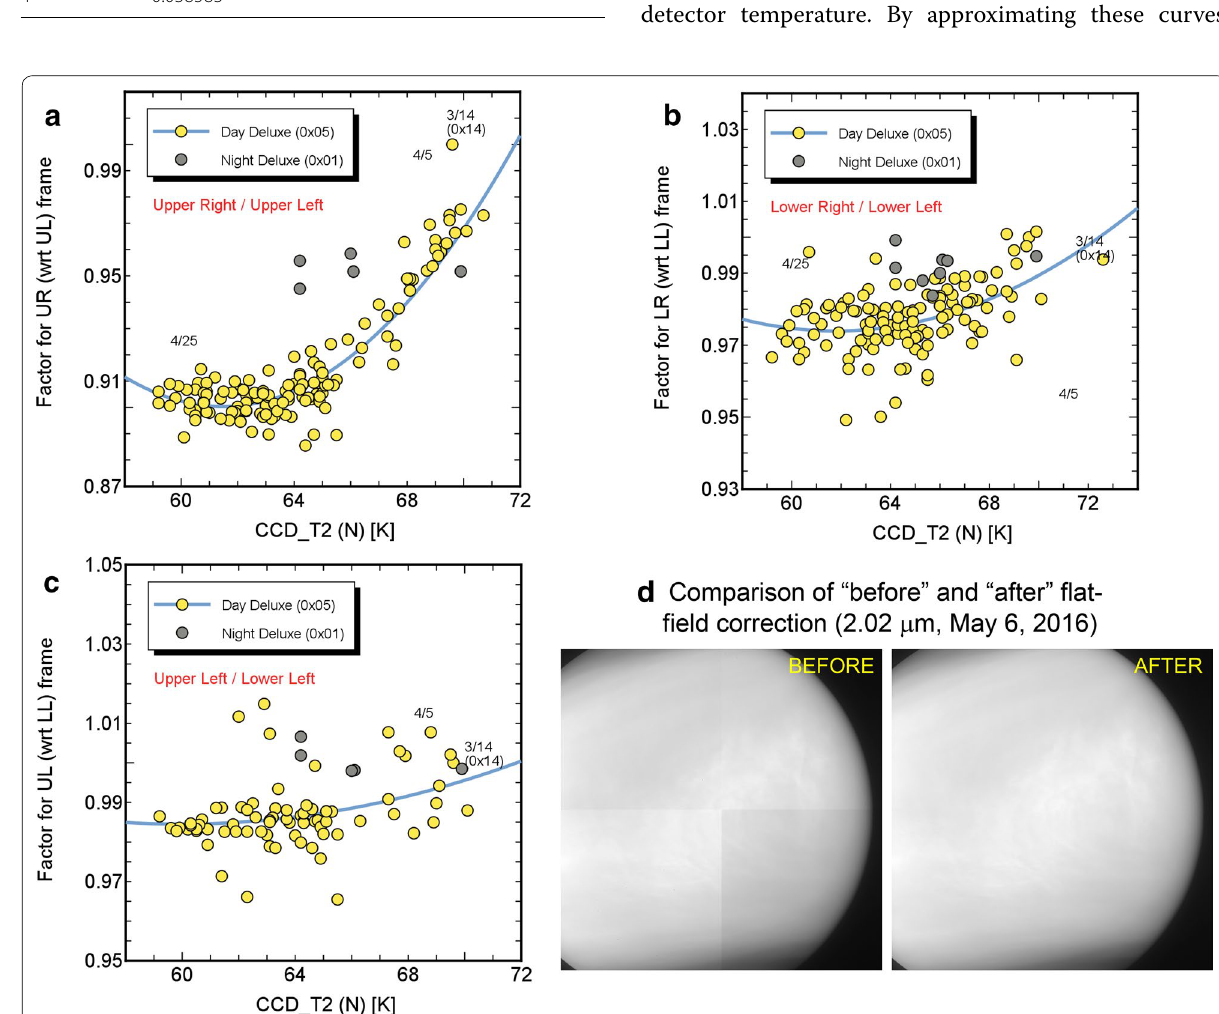
Fig. 6 Temperature dependence of correction factors for brightness variation between quadrants. a Correction between upper‑right and upper‑ left quadrants. b Correction between lower‑right and lower‑left quadrants. c Correction between upper‑left and lower‑left quadrants. d A demon‑ stration of the brightness correction between four